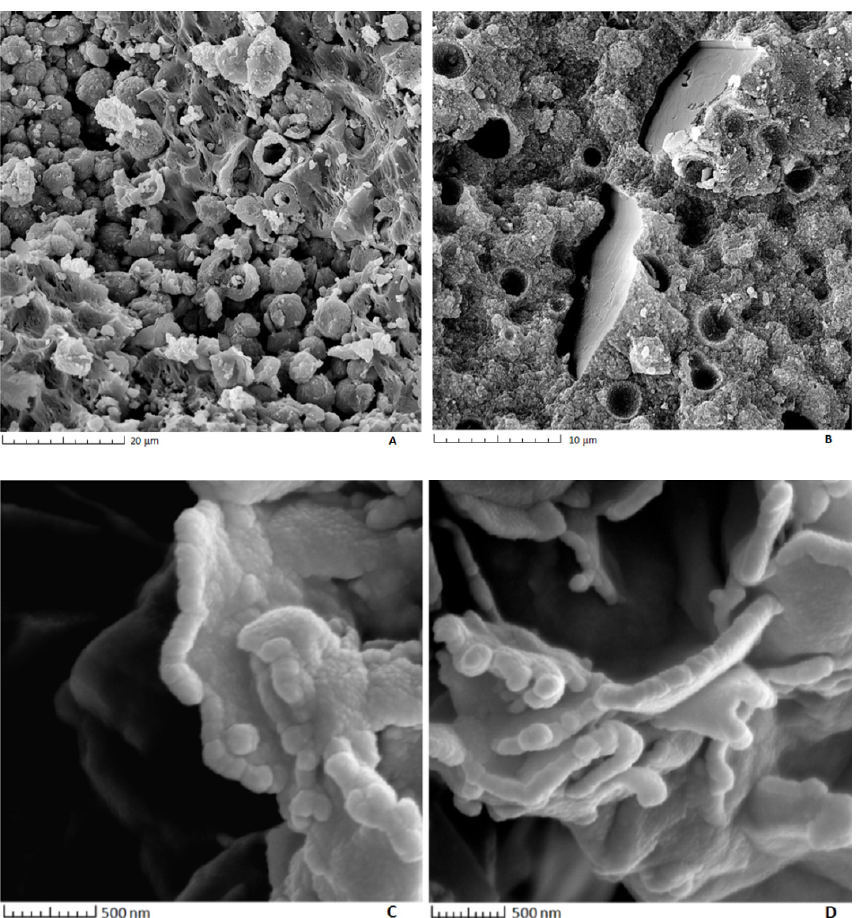
Figure 5. SEM images: ( A , B ) Cyanobacteria in phosphate coprolites. ( C , D ) Sulfur-reducing bacteria in phosphate nodules (adopted from Reference [23] with minor modification).